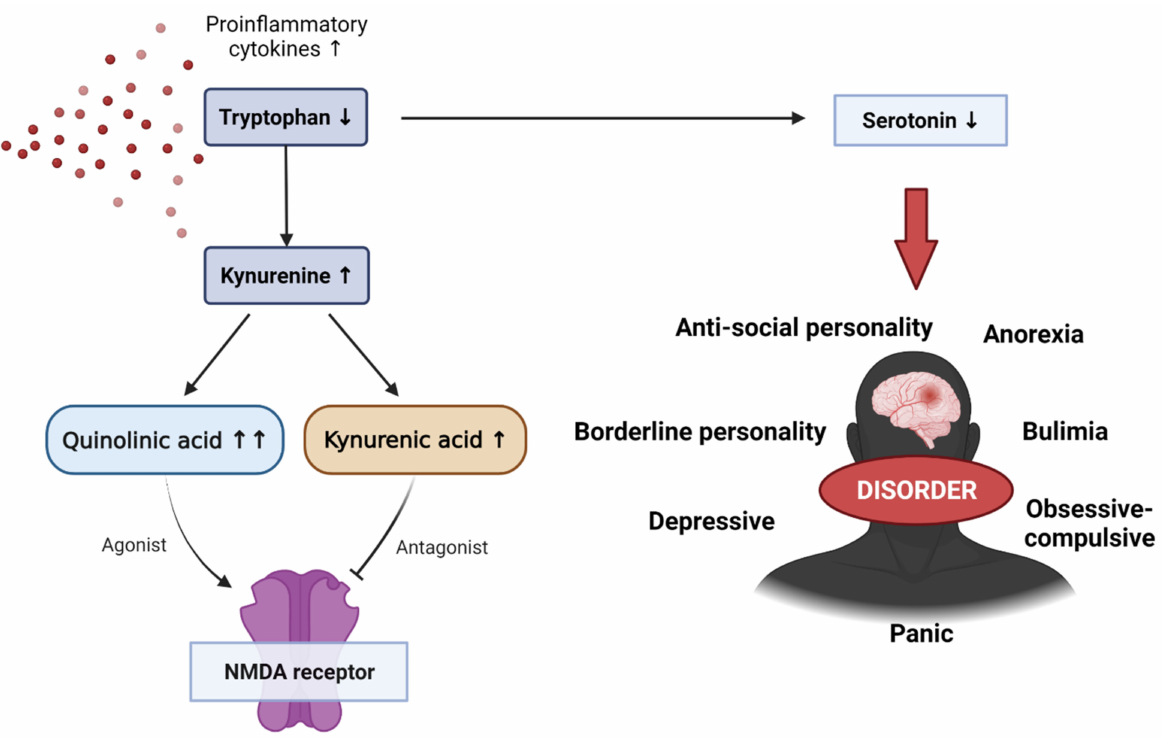
Figure 4. The effect of reduced tryptophan on the kynurenine pathway, as well as various emotional– behavioral disorders caused by a decrease in serotonin levels due to reduced tryptophan. NMDA, N -methyl- D